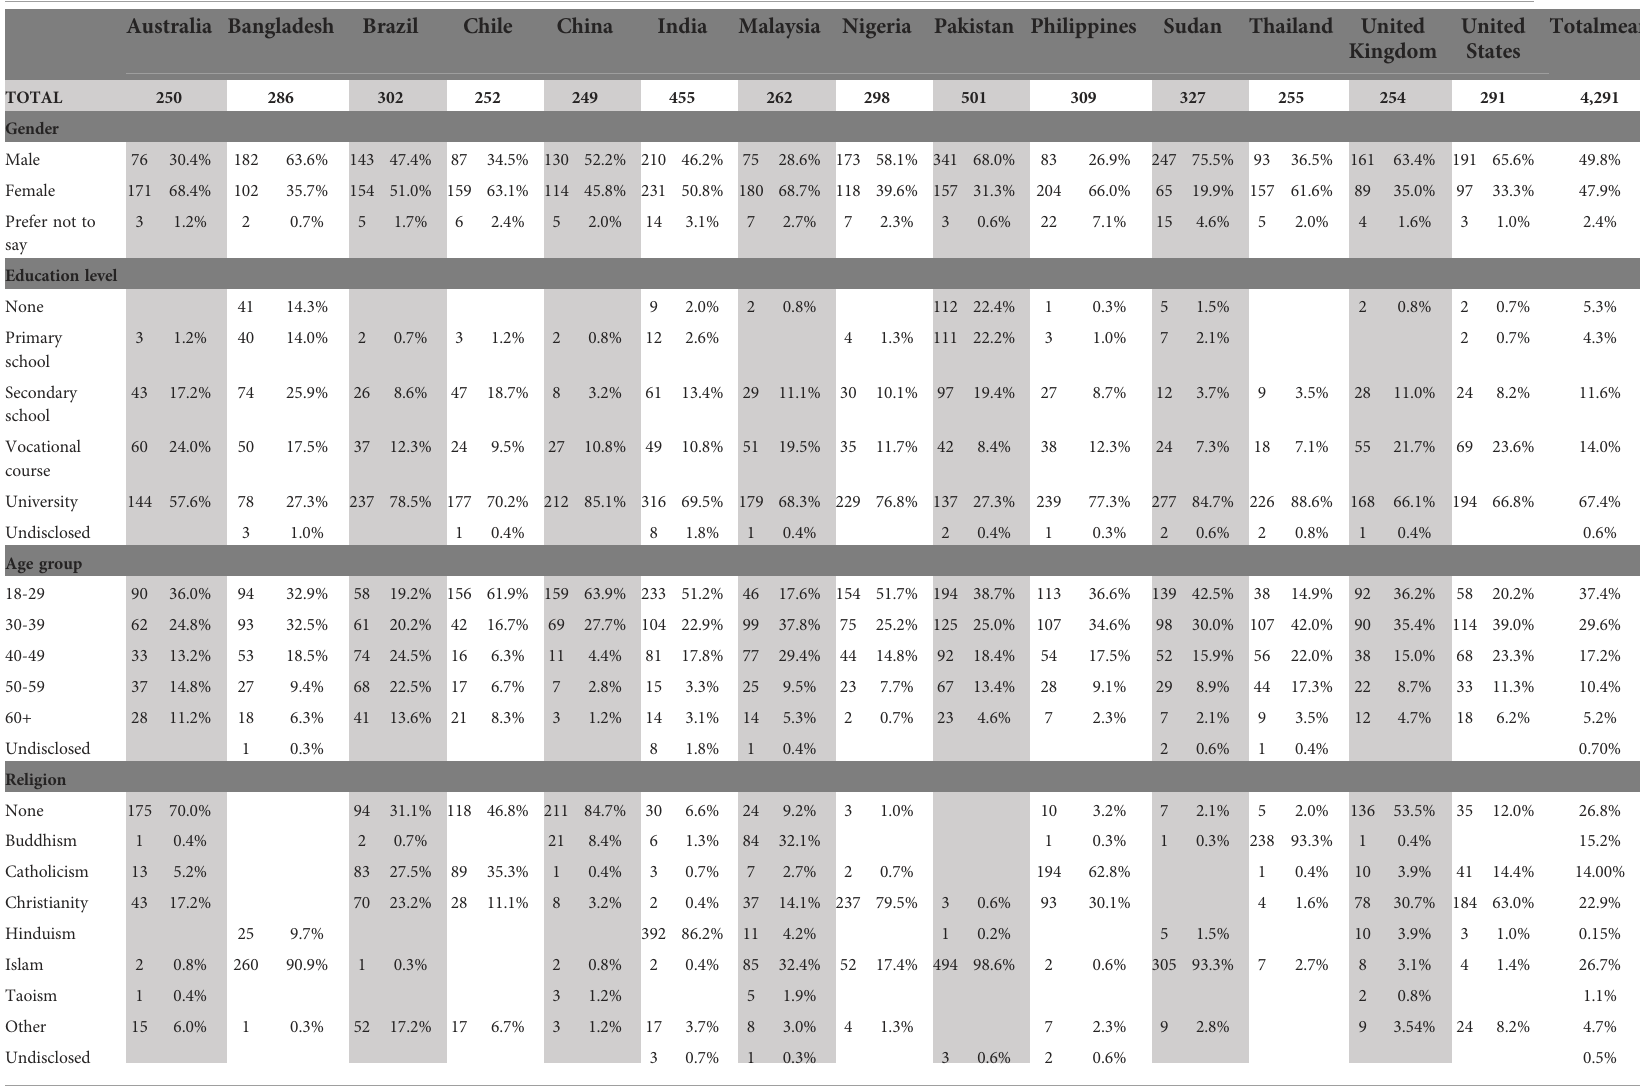
TABLE 1 Demographic characteristics of respondents (n = 4,291) in Australia, Bangladesh, Brazil, Chile, China, India, Malaysia, Nigeria, Pakistan, Philippines, Sudan, Thailand, United Kingdom and United